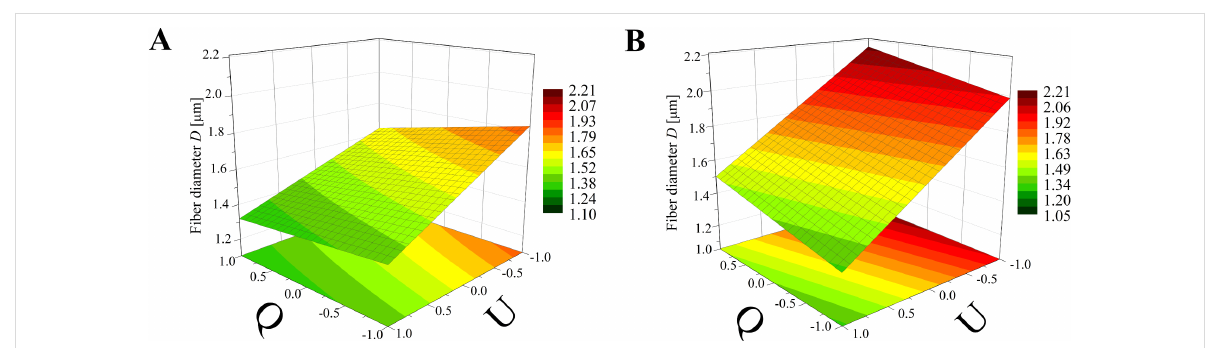
Figure 6: Response surface plots presenting the dependence of the diameter of the obtained bead-free fibers ( D ) on the electrical voltage ( U ) and the flow rate of the polymer solution ( Q ) for the (A) minimum dynamic viscosity (µ = − 1) and (B) maximum dynamic viscosity (µ = +1) .